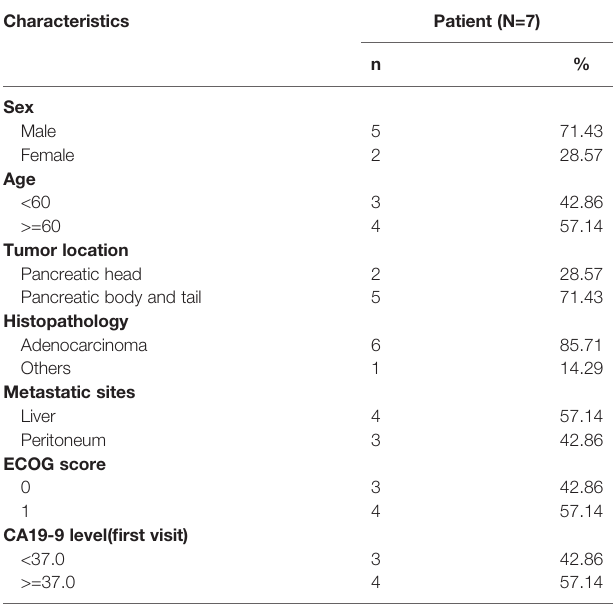
TABLE 1 | Baseline characteristics of each patient. Characteristics